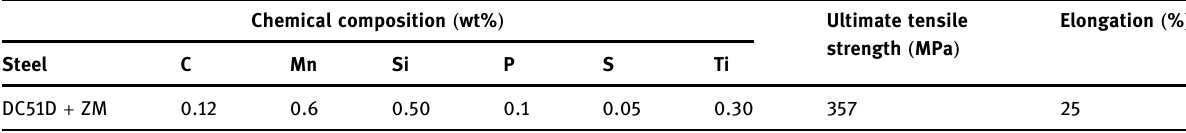
Table 1: Chemical composition and mechanical properties of DC51D + ZM Chemical composition ( wt%